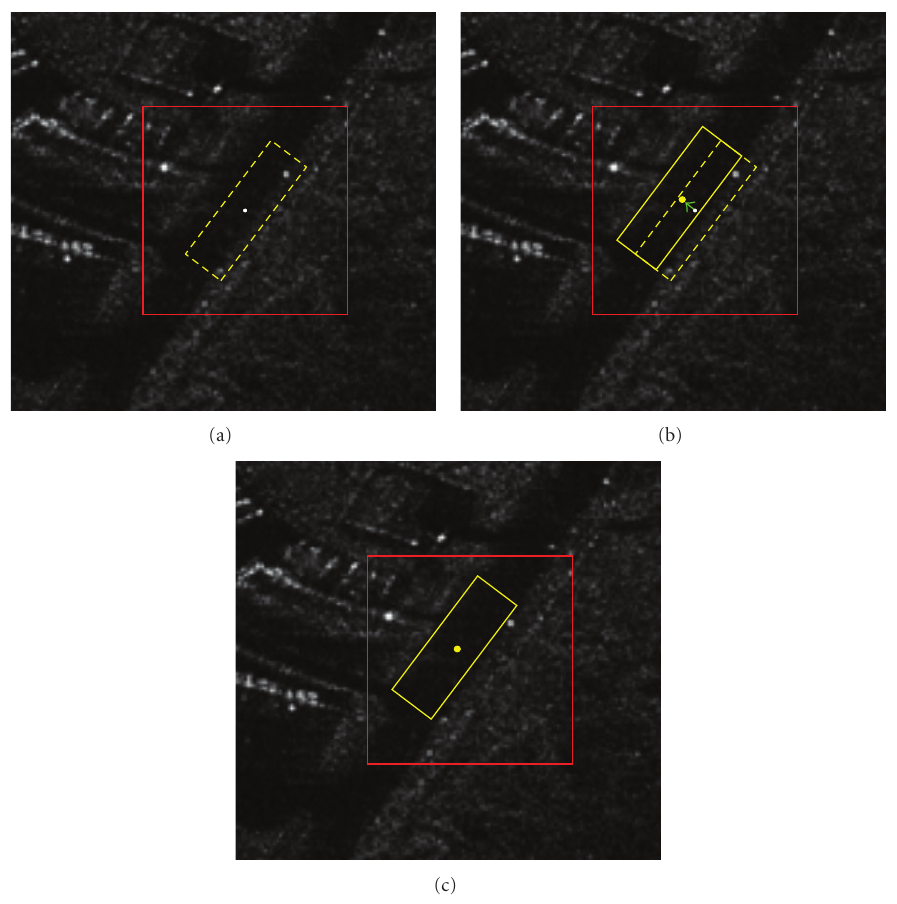
Figure 7: Initial seed point automatic update. (a) Input seed point. (b) The procedure of update. (c) Updated center-point.